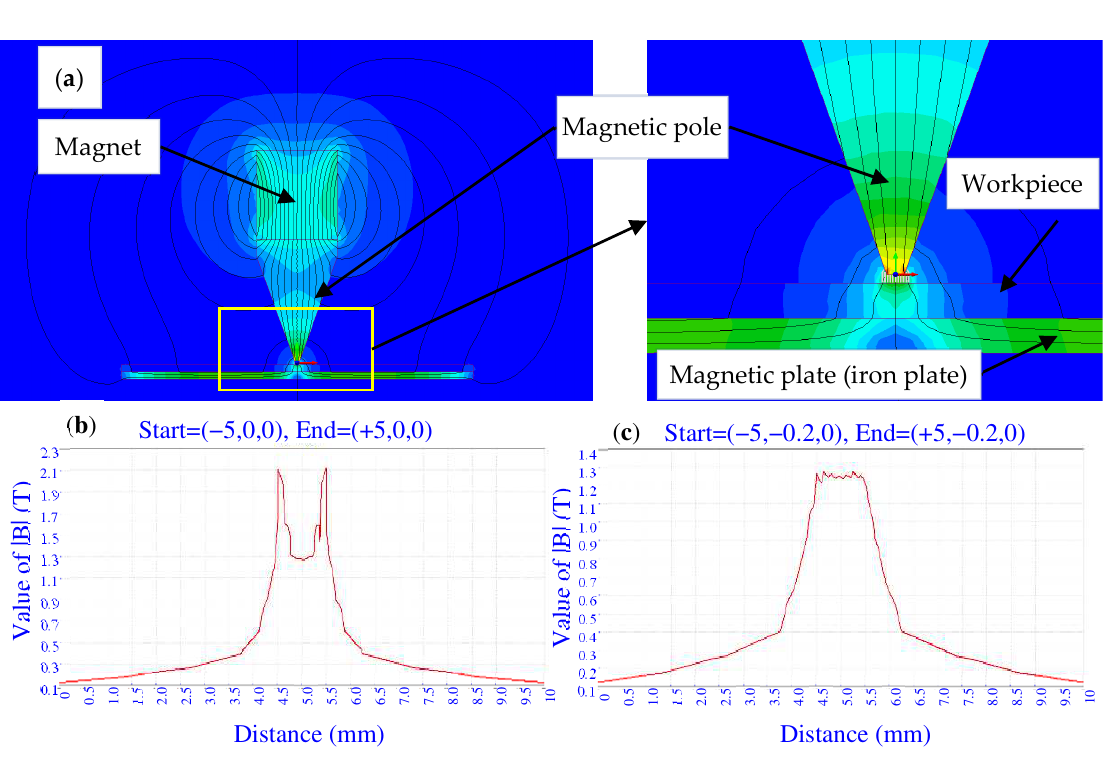
Figure 6. The simulations with magnetic particles and with the magnetic plate under the workpiece. ( a ) The magnetic field distribution near the magnetic pole; ( b ) The magnetic field intensity |B| at a distance of 0 mm from the magnetic pole; ( c ) The magnetic field intensity |B| at a distance of 0.2 mm from the magnetic